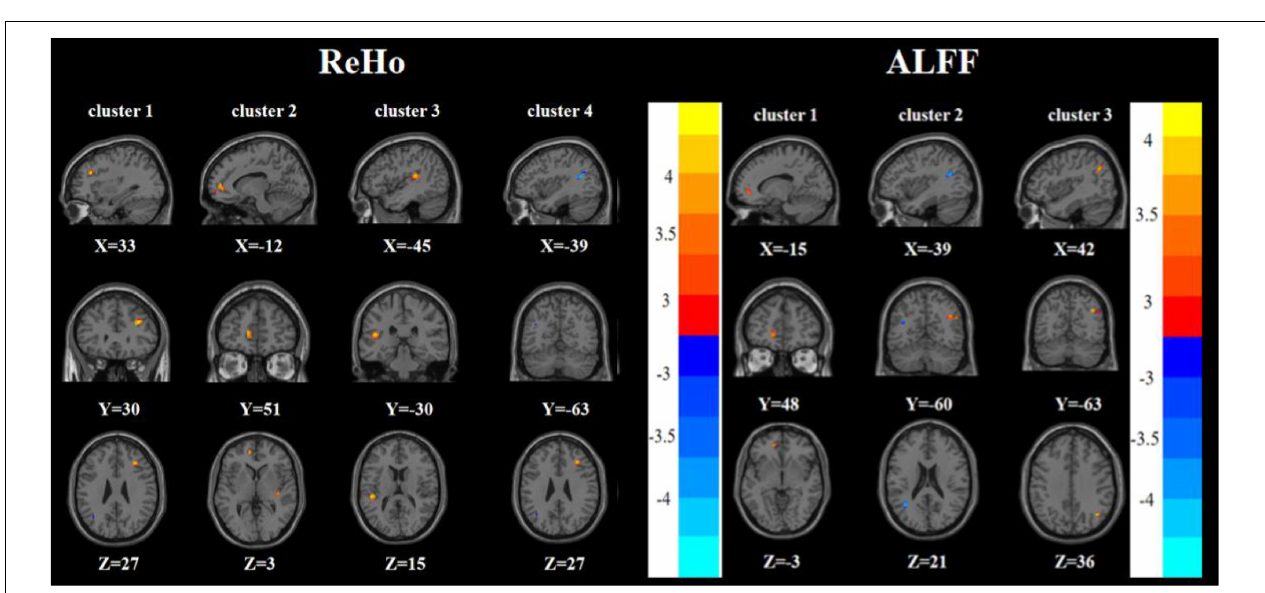
FIGURE 3 | Brain regions with abnormal ReHo (left) and ALFF (right) between the RDE group and the FDE group based on a post hoc t -test. The color bars indicate the T -value.